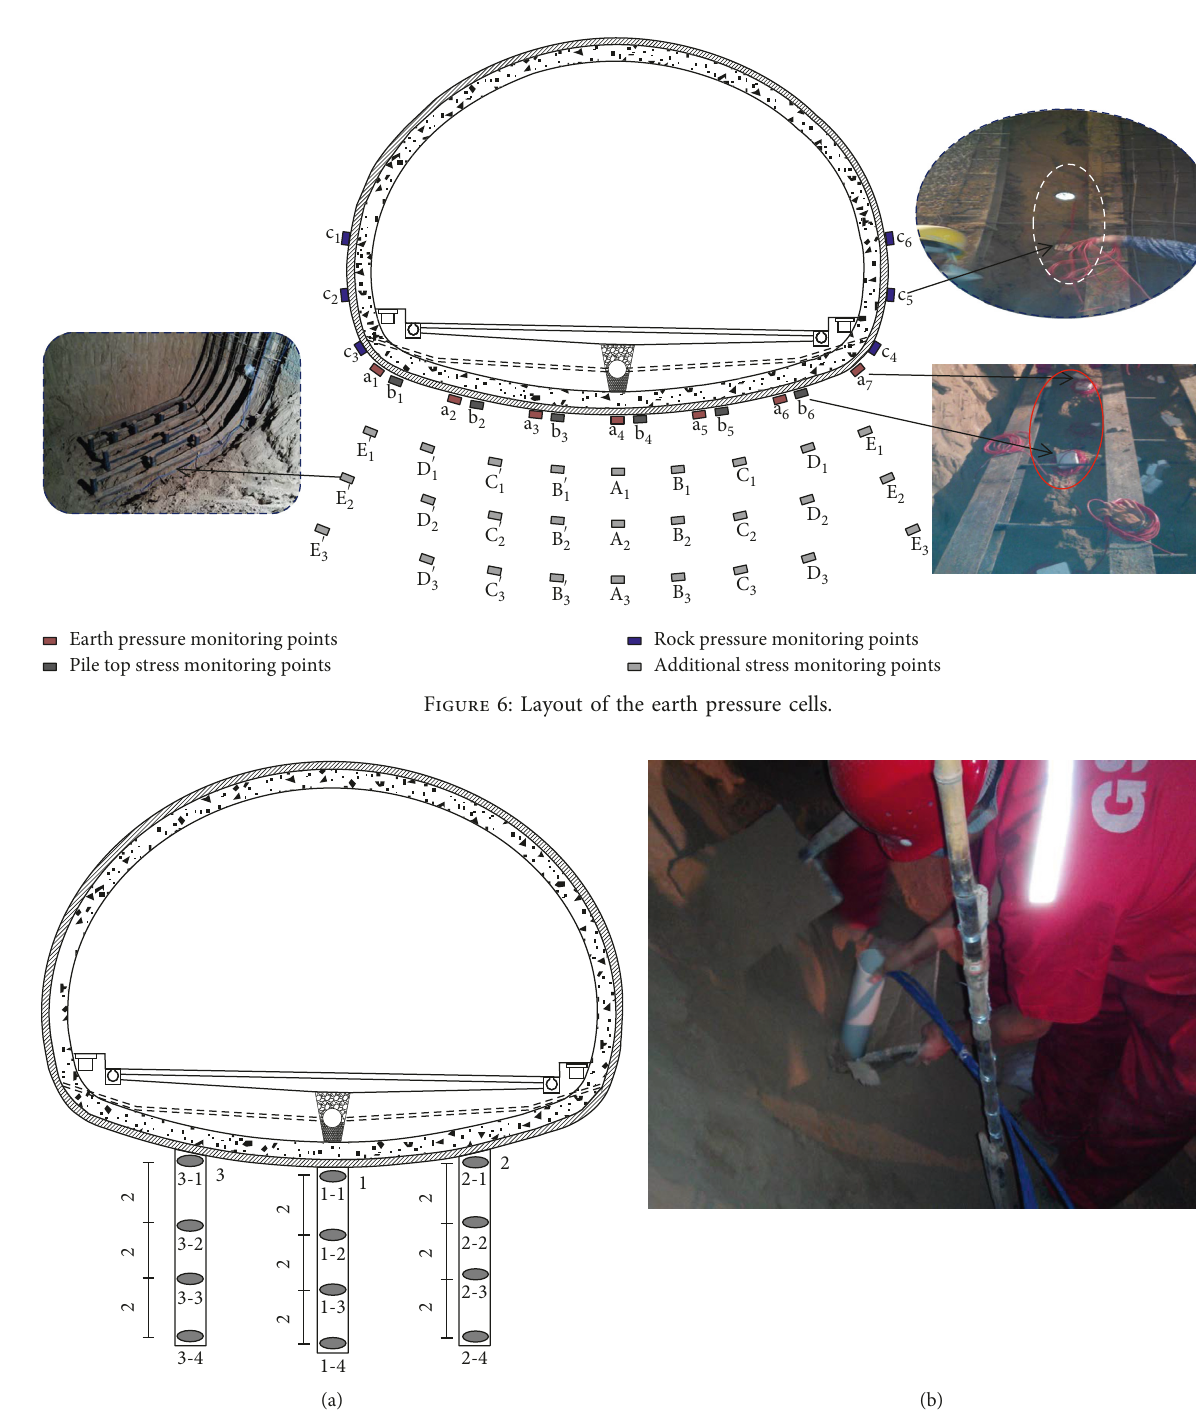
Figure 7: Layout of the layered displacement meters. (a) Arrangement of the layered displacement meters (m). (b) Buried layer dis- placement